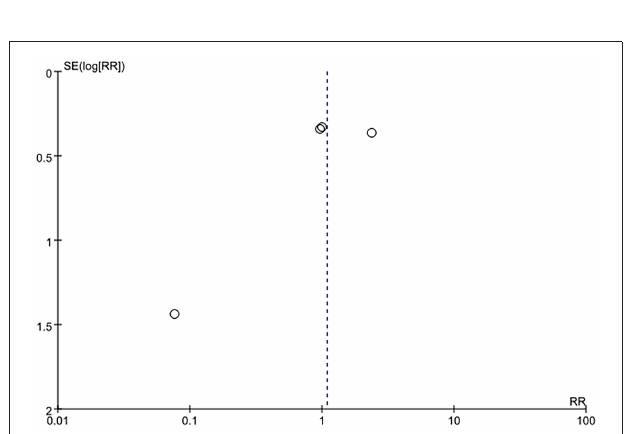
FIGURE 8 | A Funnel plot of the former smoking and non-smoking groups.